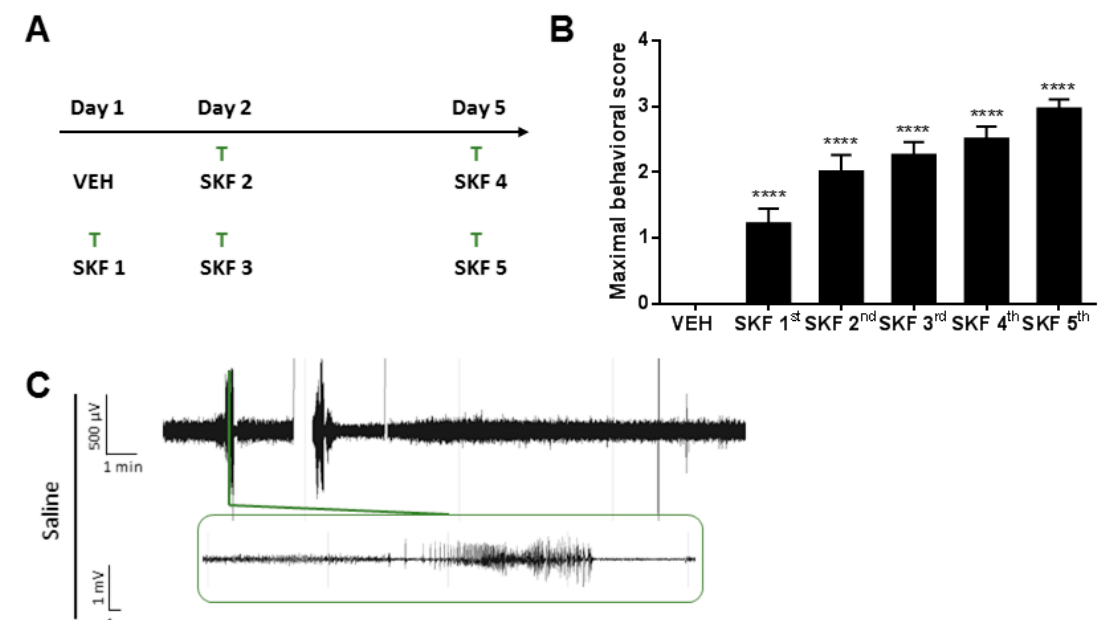
Figure 1. Overview of the D1R-mediated kindling model. ( A ) Experimental design. ( B ) Maximal behavioral score in C57BL/6J mice pooled from the three experiments ( n = 24). One-way RM ANOVA (Treatment p < 0.0001, F (5.000, 115.0) = 31.01). ( C ) Representative trace of saline-treated control mouse during SKF 5th. 0.3 Hz high-pass, 60 Hz low-pass, and 50 Hz power line filters were applied. Data are presented as mean ± SEM. **** p < 0.0001. µV, microvolt; mV, millivolt; min, minute; s, second; SKF, SKF81297; T, treatment; VEH, vehicle.